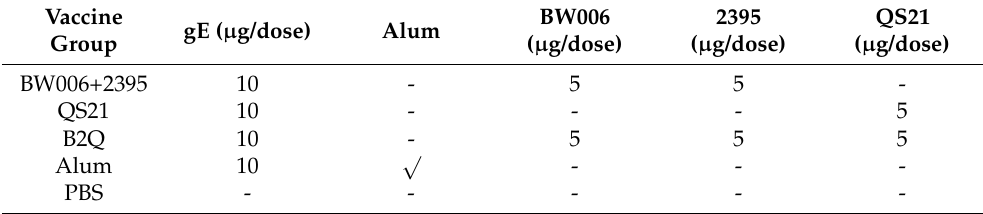
Table 1. Composition of each dose of vaccine for the adjuvant synergy study.